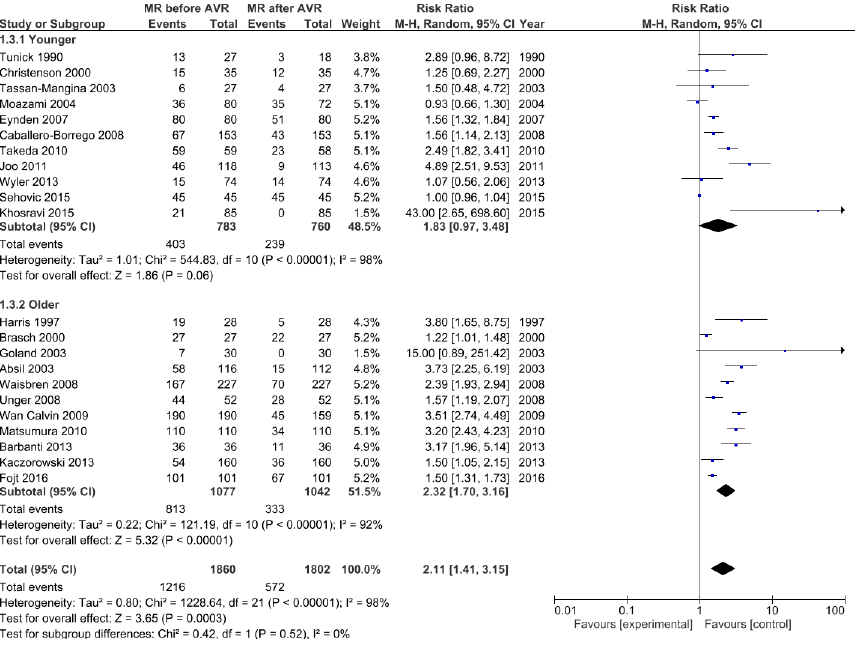
Figure 4. The forest plot of risk ratio of MR after AVR. The outcome: moderate/severe MR.